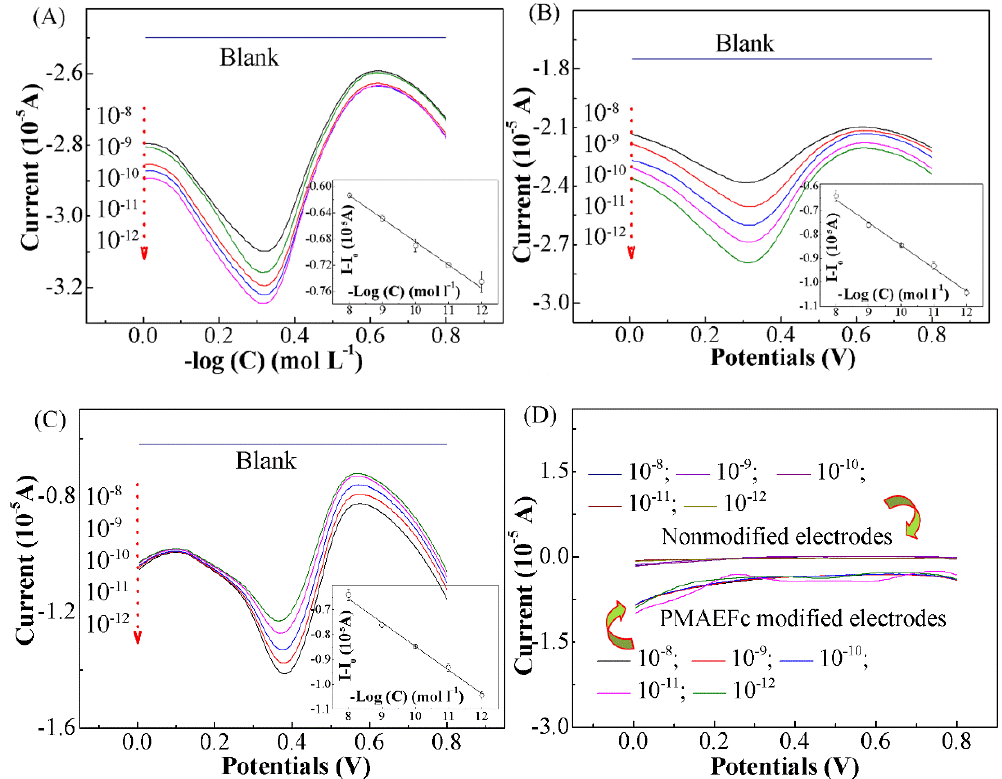
Figure 7. DPV curves of ( A ) C1, ( B ) C2, ( C ) C3, and ( D ) nomodified and PMAEFc modified electrodes with different aspartame concentrations in 0.2 M PBS solution of pH = 2; and the insets represent corresponding linear relationship between peak currents ( I p ) and aspartame concentrations.